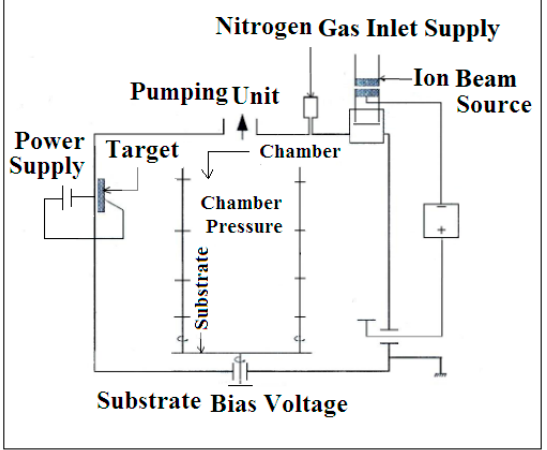
Figure 2. Representation outline sketch for the CAP-PVD system. (Source Diagram provided by OerlikonBalzers Limited, Balzers, Liechtenstein) Table 1. As-Received Powder Specification.